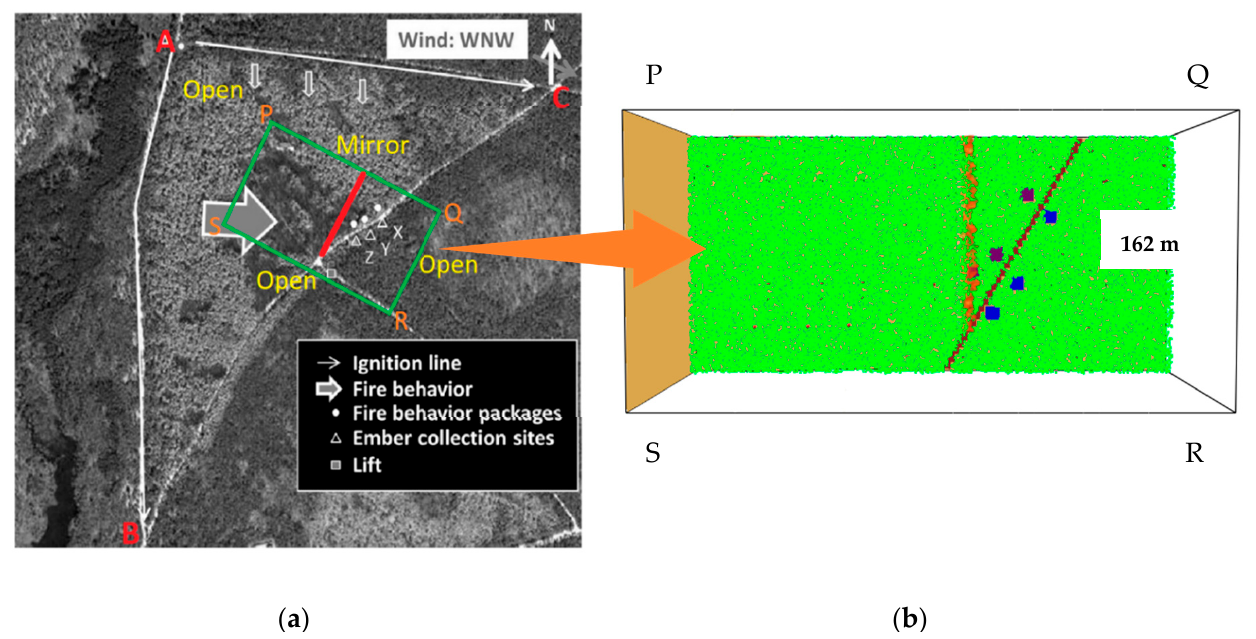
Figure 4. ( a ) A post-fire satellite image of the PNR burning plot [28]. The X, Y, Z Firebrand Collection Sites (FCS) are located at the right side of the dirt road. Fire Behavior Packages (FBP) are established on the left side of the dirt road opposite to the FCSs. The wind direction is WNW. The focused area for modeling is marked in a green color rectangle (not to the scale). The red color line is the fireline location at a certain time. ( b ) Snapshot of Smokeview of the focused area of the FDS modeling including the major locations of the burning site.